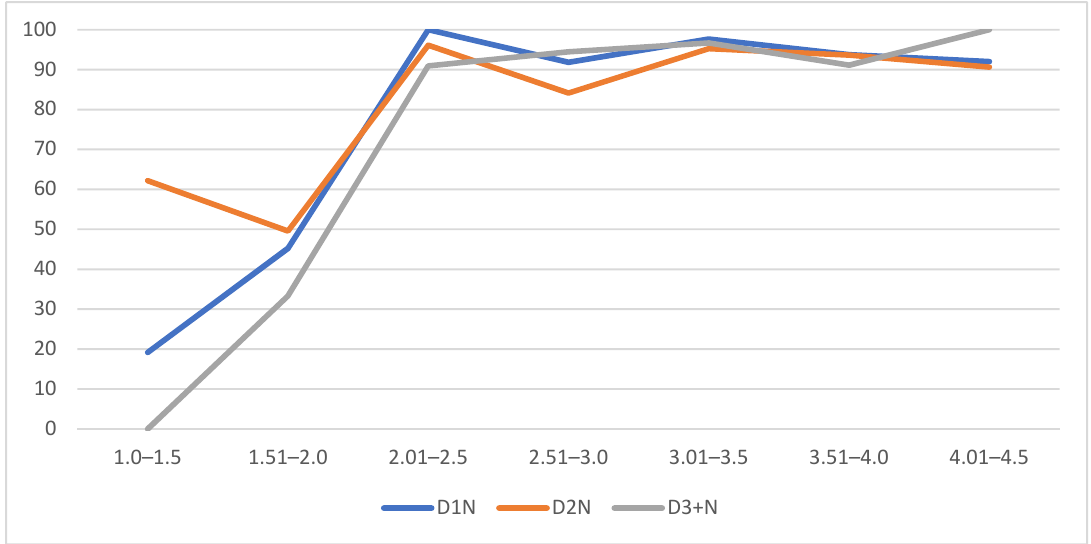
Figure 4. Si_fi’s D realizations according to noun length (%).